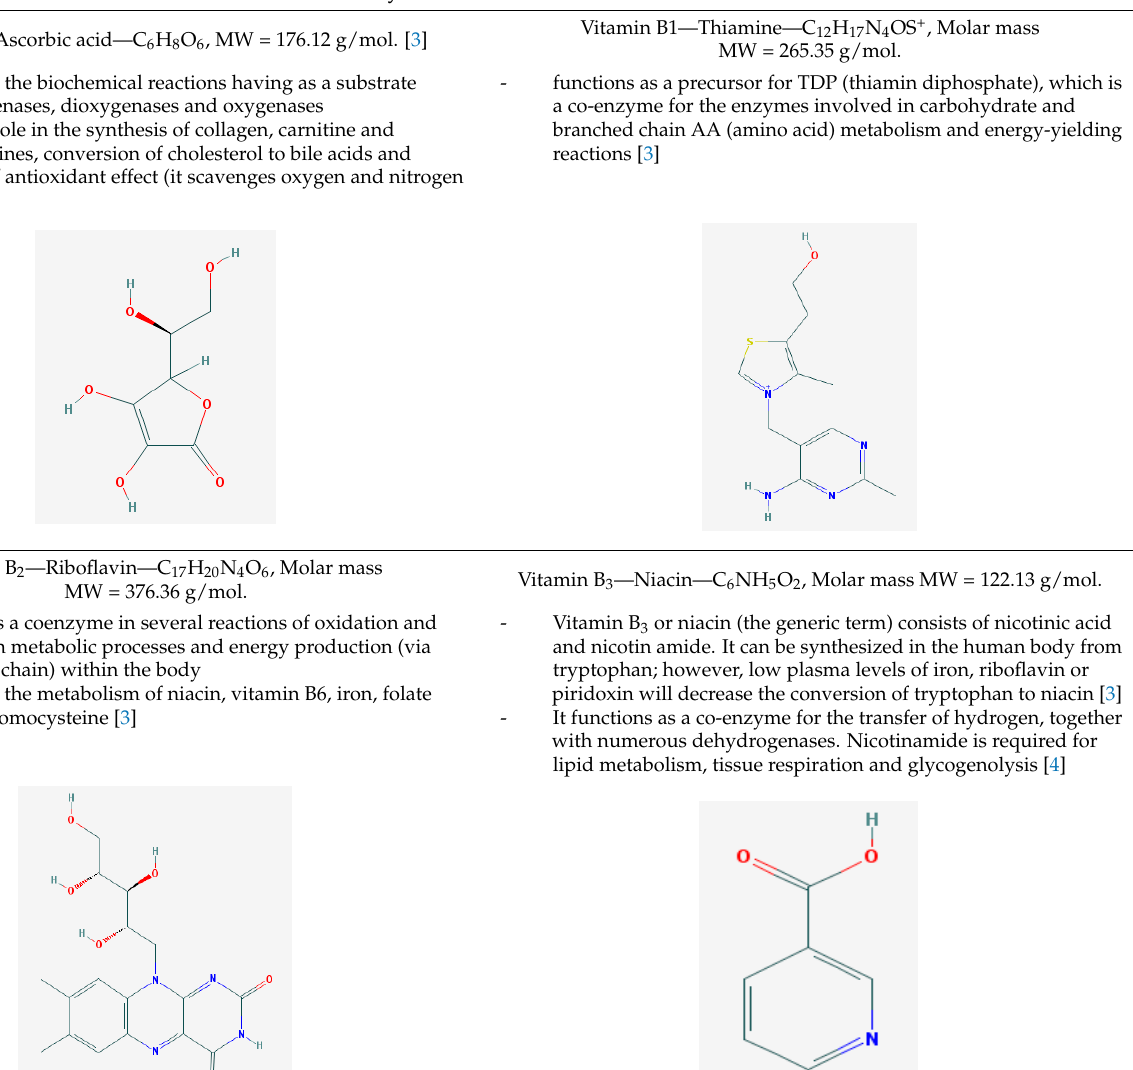
Table 1. 2D structural formulas and the main biological functions for hydro- and lipo-soluble vitamins. Hydro-Soluble Vitamins